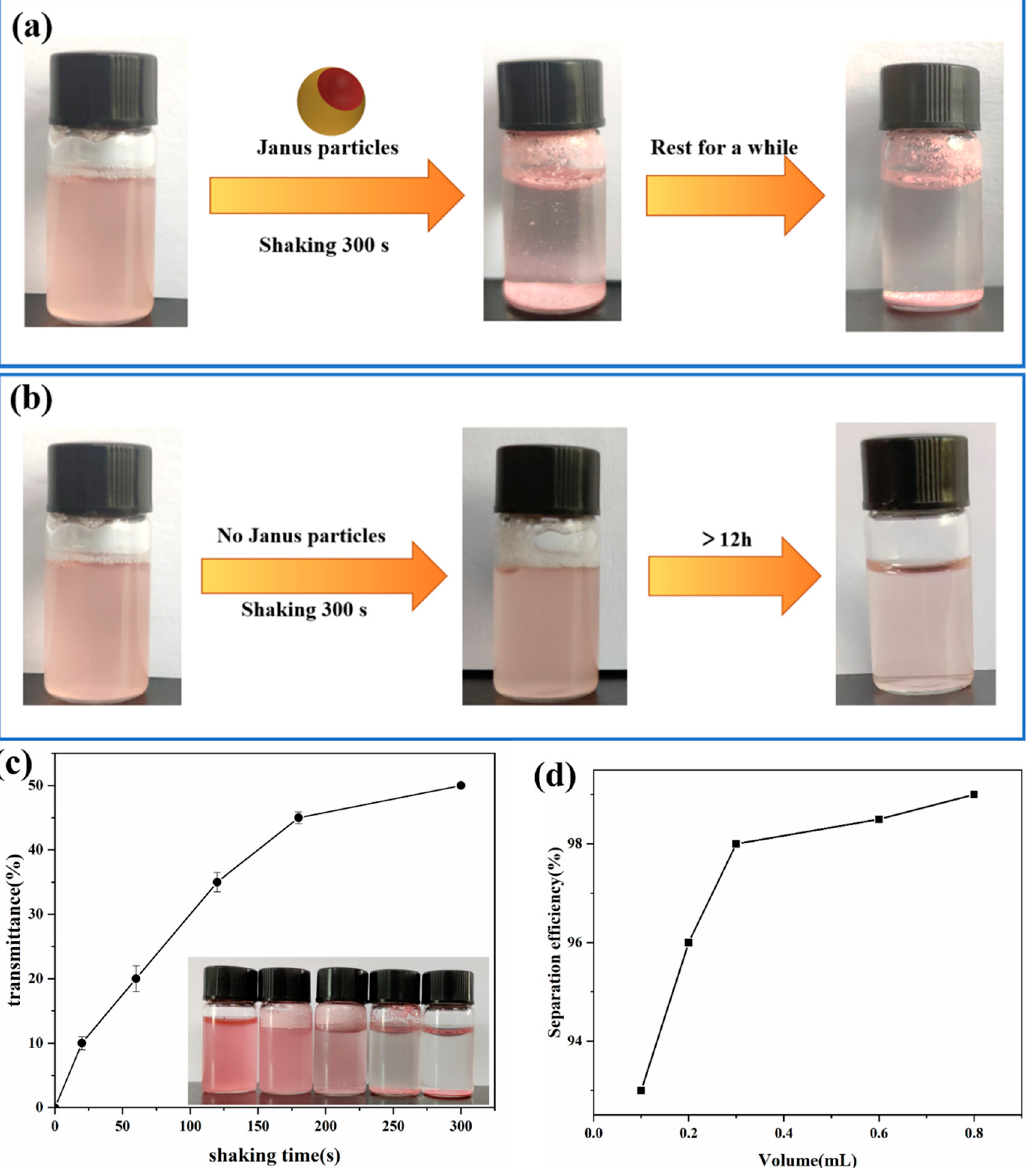
Figure 8. ( a ) Photographs of Janus-particle-mediated separation of n-heptane-in-water emulsion (volume ratio of 1:100). ( b ) Photograph of n-heptane-in-water emulsion without the addition of Janus particles. ( c ) Effect of the shaking time on the oil–water separation by Janus particles. ( d ) Effect of the added amount of Janus particles on the separation efficiency of n-heptane–water emulsion (3% n-heptane, v / v ).